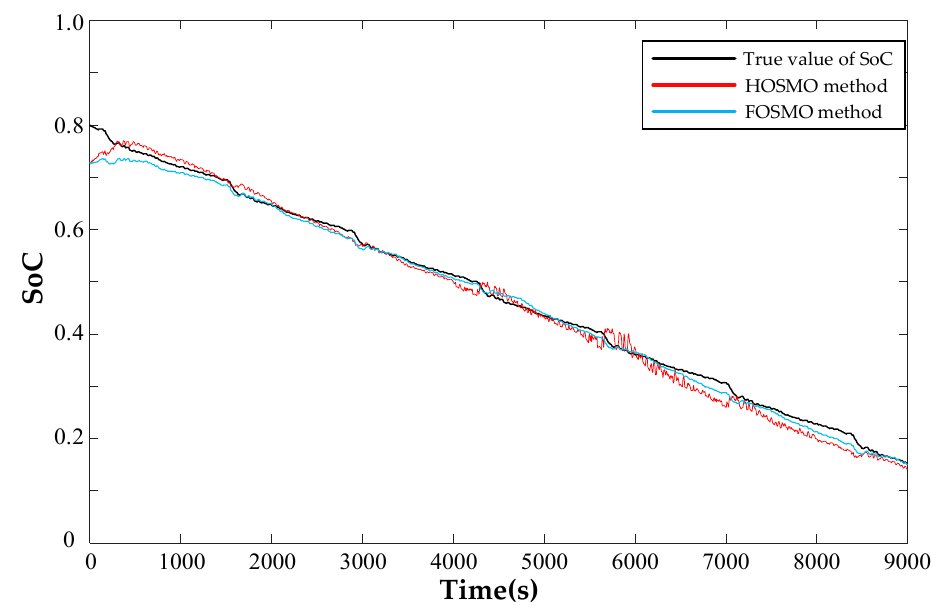
Figure 6. The current and terminal voltage of the lithium battery from FUDST.